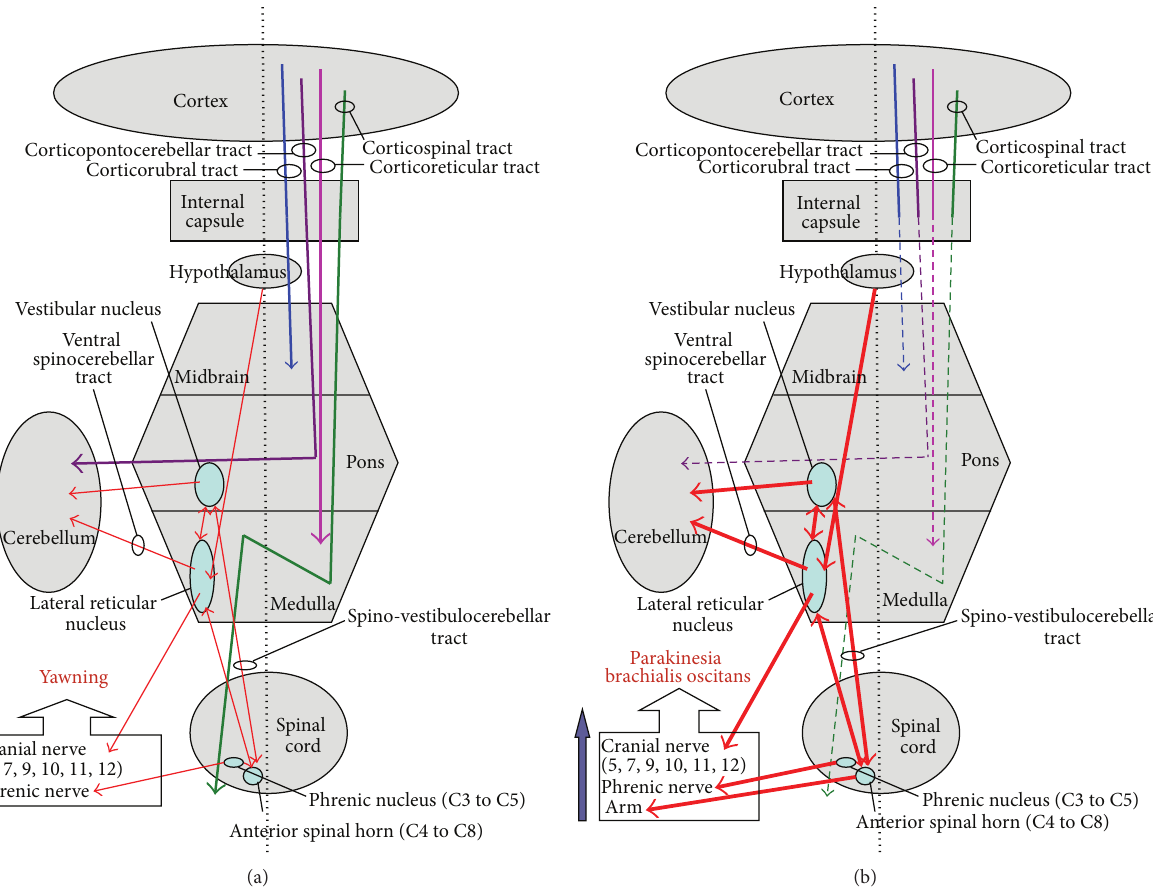
Figure 2: (a) Schematic representation of neuroanatomical pathways of yawning system. (b) Schematic representation of neuroanatomical pathways of crossed cerebellar diaschisis and parakinesia brachialis